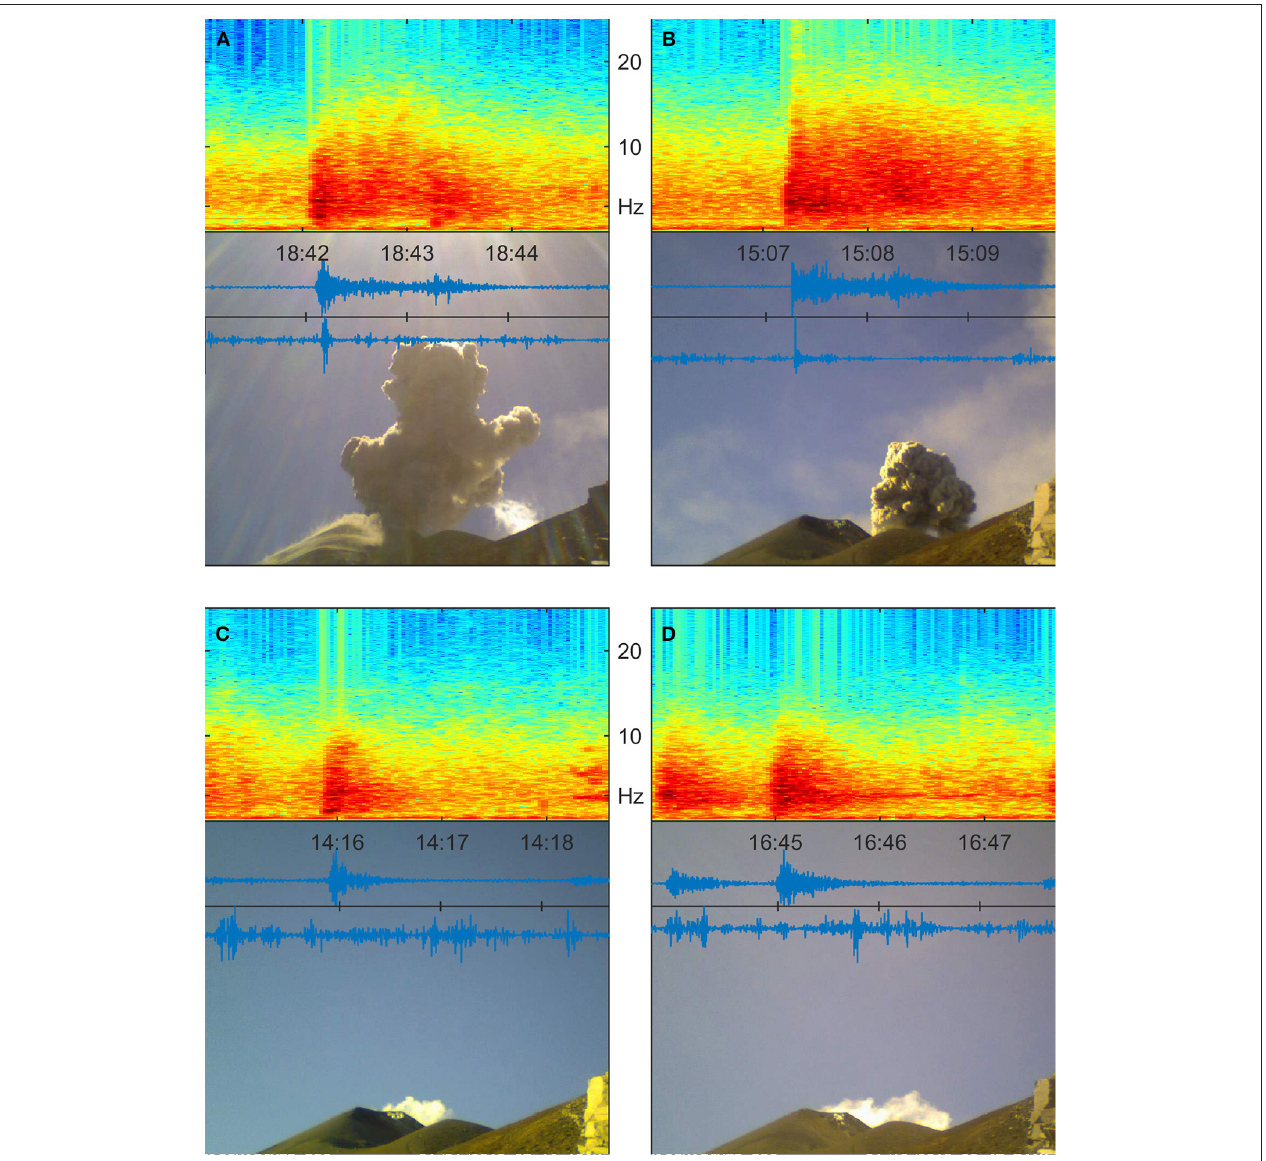
FIGURE 6 | Examples of summit emissions recorded at station NE1 plotted together with images from the time-lapse camera that was located near the seismic station. The spectrogram of the vertical component is plotted above the trace of the same time. The lowest trace is from a collocated infrasound sensor. Trace units are normalized. (A) Summit Impulsive (B) Flank Impulsive (C) Summit Emergent (D) Flank